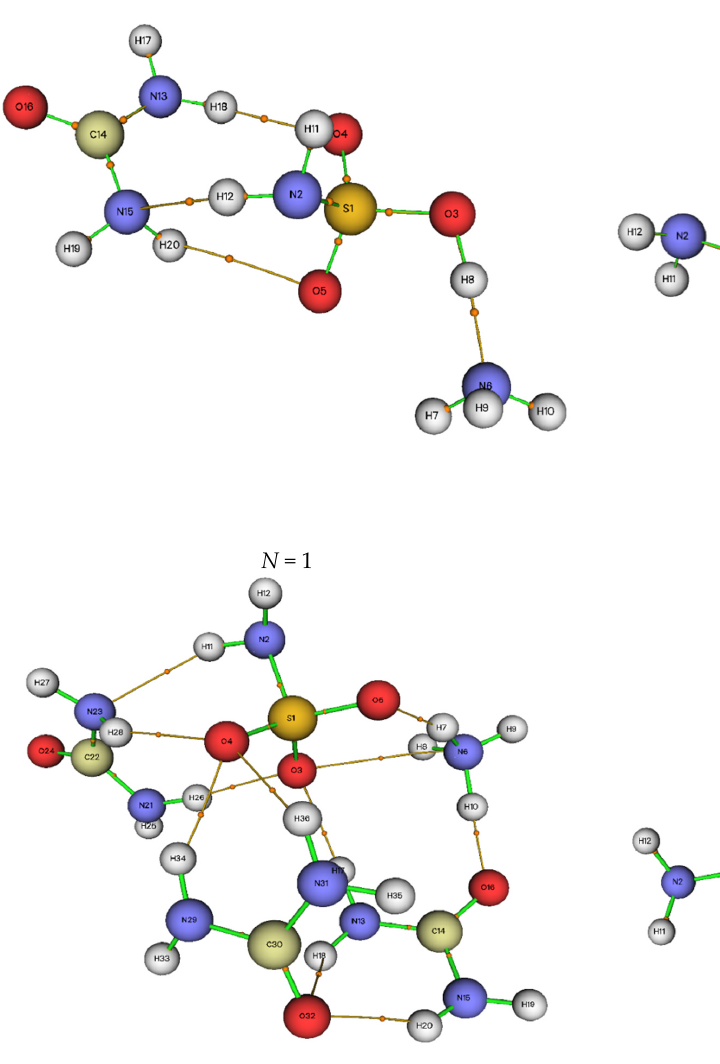
Figure 8. MEP contour maps for ( a ) ASA–urea1, ( b ) ASA–urea2, ( c ) ASA–urea3, and ( d ) ASA– urea4.